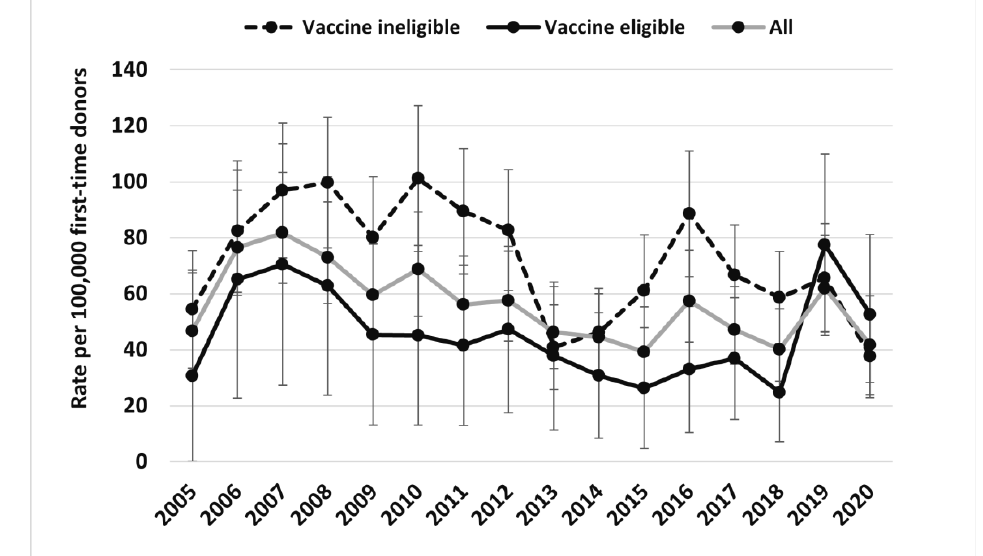
Figure 1. HBV clinical scenario 2 (likely chronic infection) rate (per 100,000 first-time donors) (95% confidence intervals) by vaccine age eligibility based on provincial routine programs from 2005 –